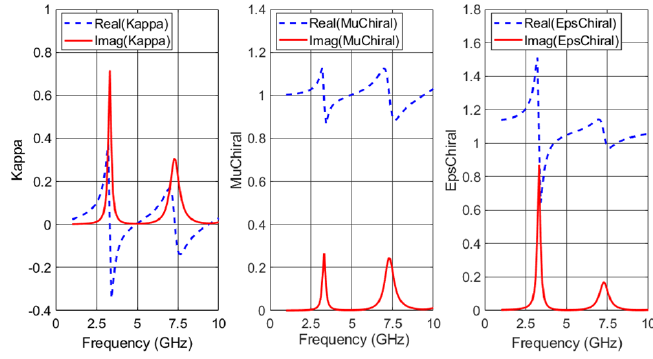
Figure 5: Complex Normalized Relative Material Parameters for Host Loaded with 3-Turn 30º Conical